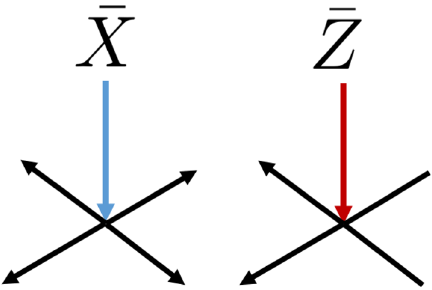
Figure 15. A logical operator in the construction (4.10) admits pushing rules given by the above tensor network representation. The rule also applies for multi-copy skewed codes, where a number of copies were replaced by this type of skewed code. In the multi-copy case, a logical Z operator can be pushed to any 2